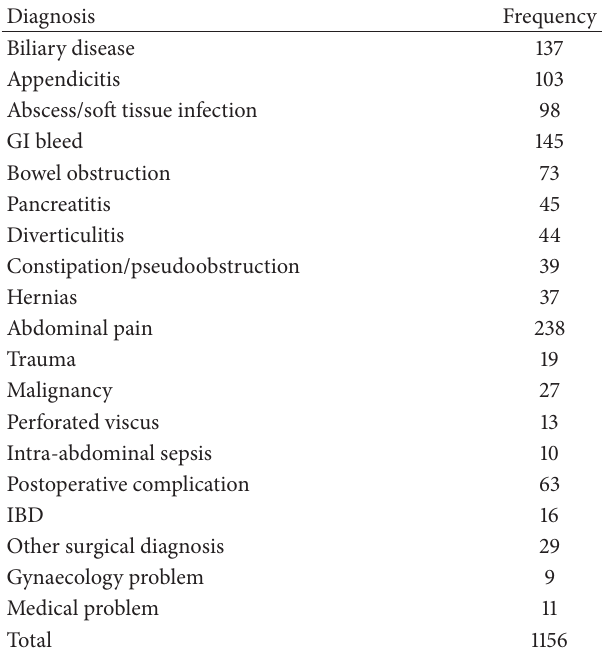
Table 1: Emergency general surgical admissions.